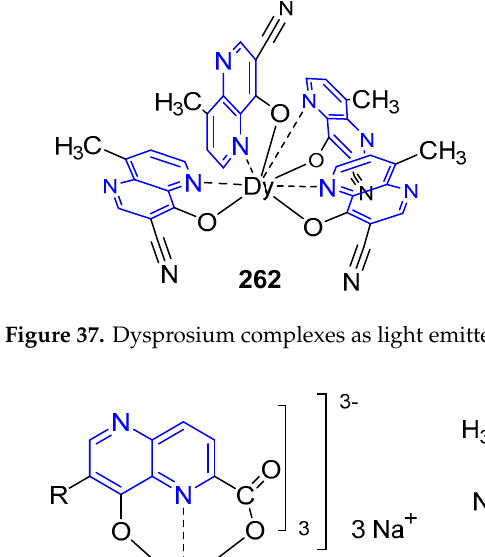
65 of 75 Figure 36. Platinum complexes as WOLEDs.